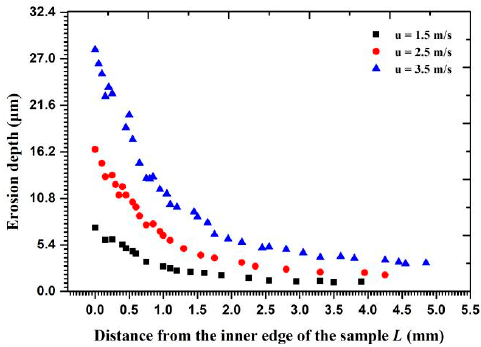
Figure 18. Metal erosion depth under particle cluster impacts at different flow velocities.